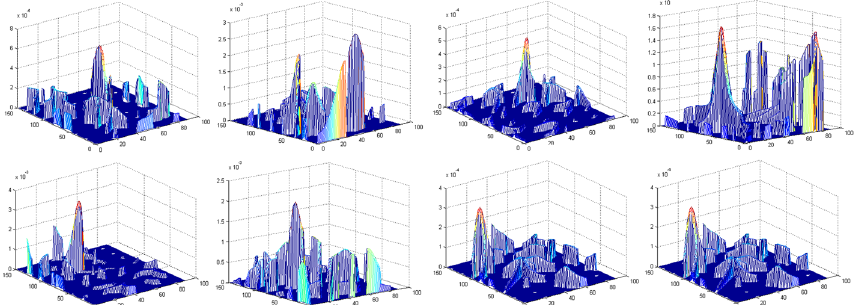
Fig. 15 Matching correlation surfaces under rotational